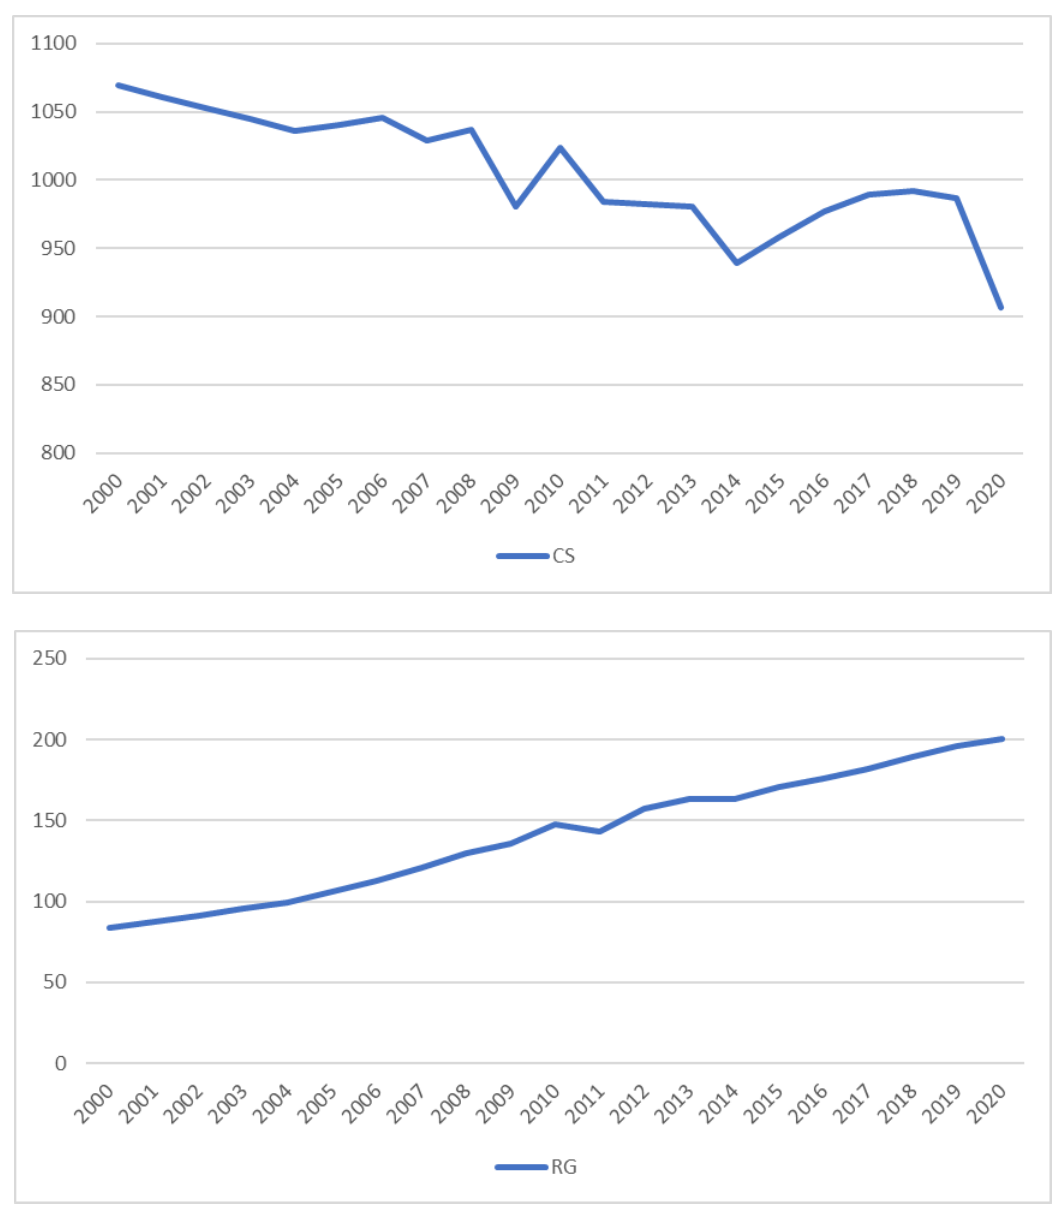
Figure 1. It’s the evolution of final energy consumption (CS) and renewable energy (RG)—million tons of oil equivalent.